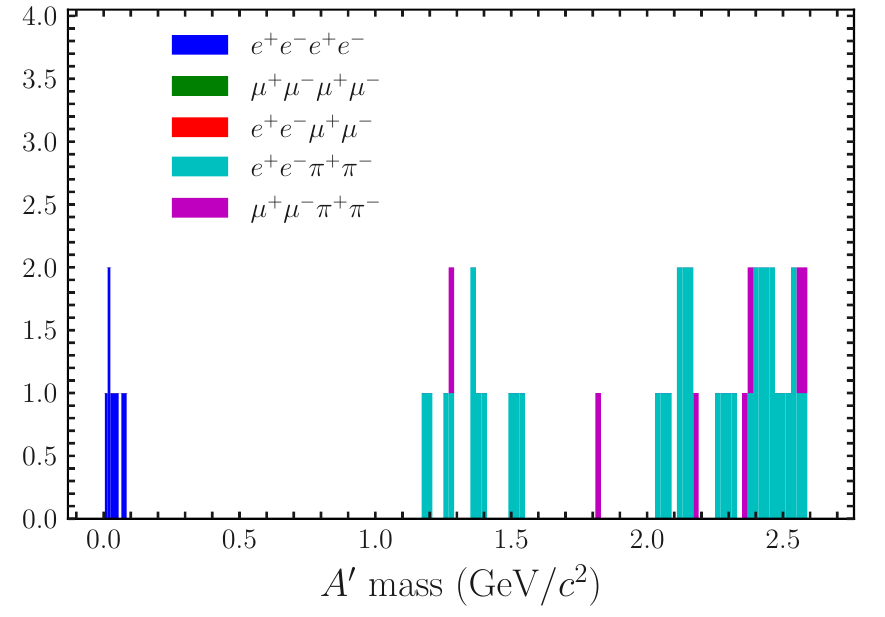
Figure 3 . The number of B 0 → A 0 A 0 candidate events for each final state.